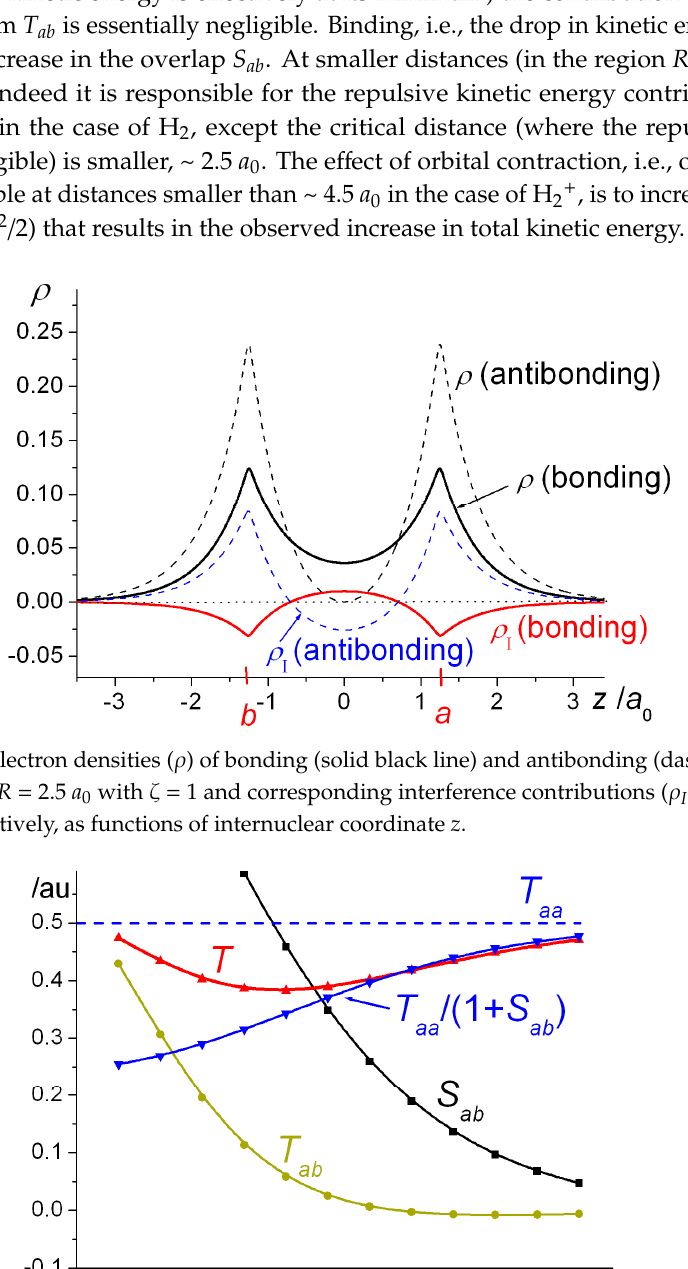
Figure 4. Interference density in H 2+ for optimized exponent  = 1.239 and bond length R e = 2.0 a 0 (red line), with nuclei at z =  1 a 0 , compared with interference densities for  = 1 and R e = 2.5 a 0 (black line) and relative to H atoms with  = 1 (blue line) as functions of the internuclear coordinate z . The physical origin of orbital contraction, in particular why it is limited to shorter internuclear distances, is elucidated in detail in previous publications. [58,59,83] Briefly, the additional interference density that results from orbital contraction brings about an additional interatomic